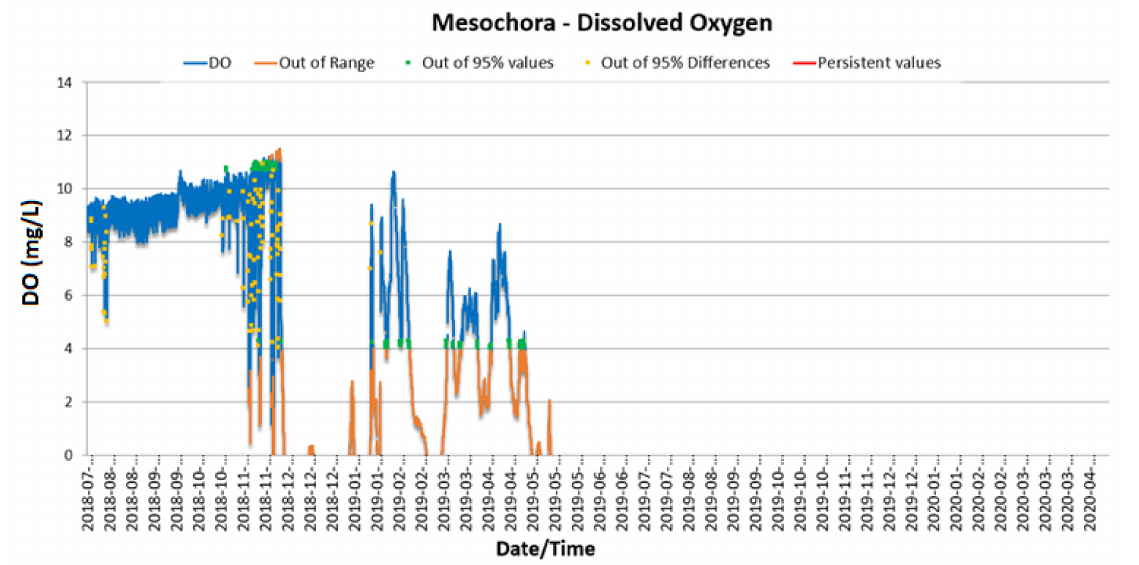
Figure 6. Change of dissolved oxygen (DO) (blue line) on an hourly basis at Mesochora station and flagging of values that are outside the allowable range (orange color), outside the 2.5% and 97.5% percentiles of observations (green color) and outside the 2.5% and 97.5% percentiles of absolute differences of consecutive observations (yellow color). No unchangeable DO values for more than two days of continuous recording (red color) have been indicated.